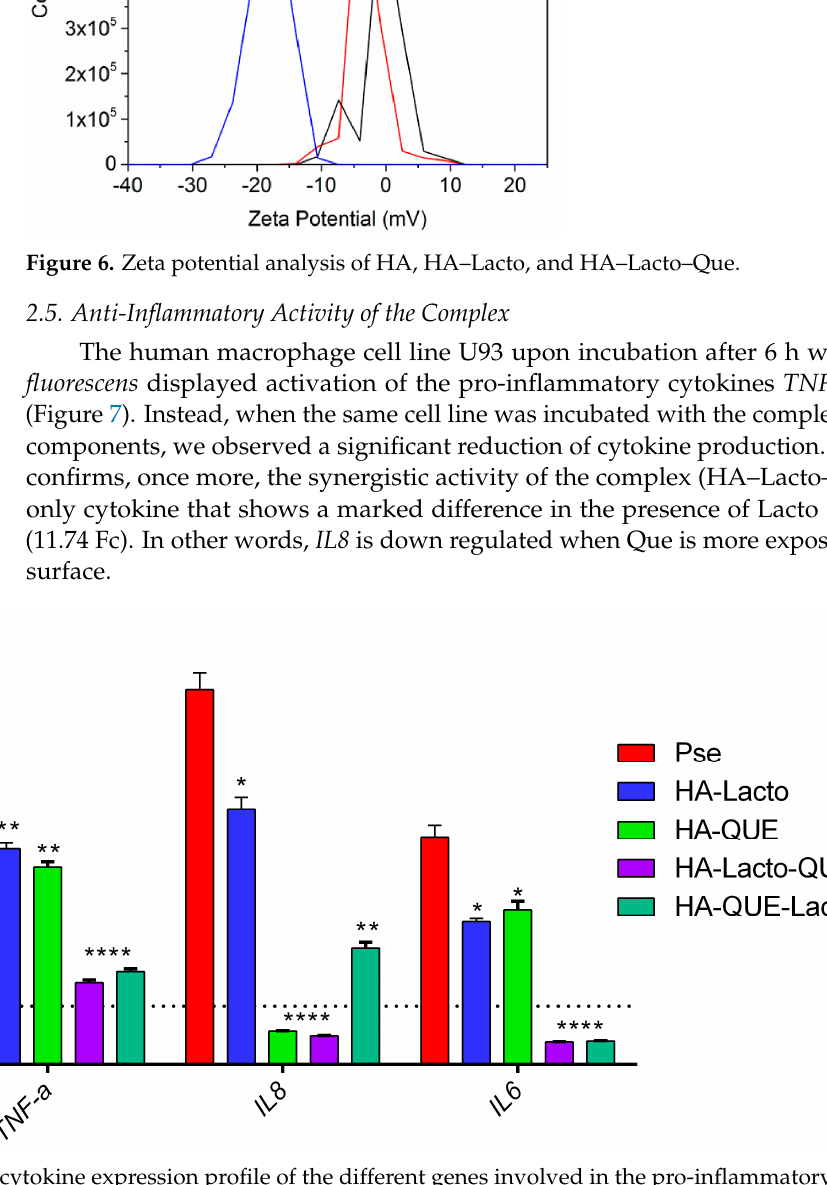
Figure 7. Real-time PCR cytokine expression profile of the different genes involved in the pro-inflammatory response of U937 cells in the presence of Pseudomonas fluorescens and the complexes for 6 h. Statistical analysis was performed and considered statistically significant when p < 0.05 (* p < 0.05, ** p < 0.01, **** p < 0.0001) according to two-way ANOVA multiple